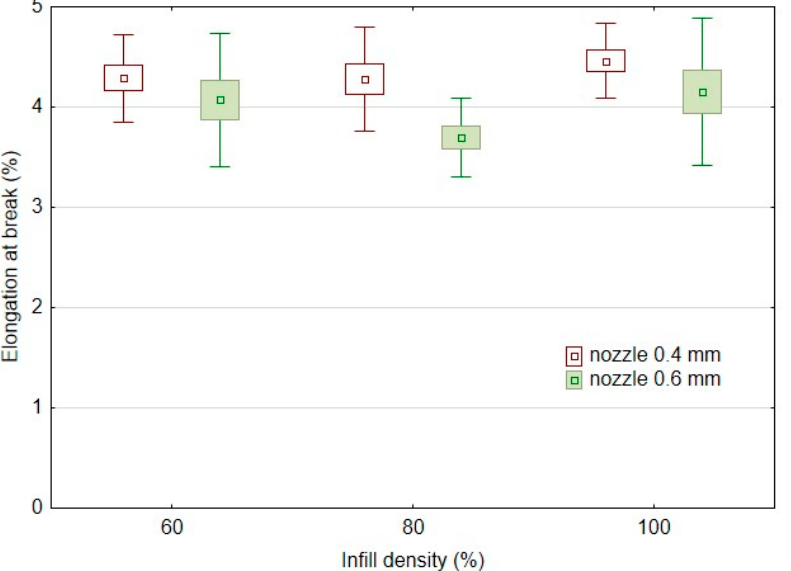
Figure 7. Effect of infill density on elongation at break in low-cycle testing using FDM 3D printing with different nozzle diameters.